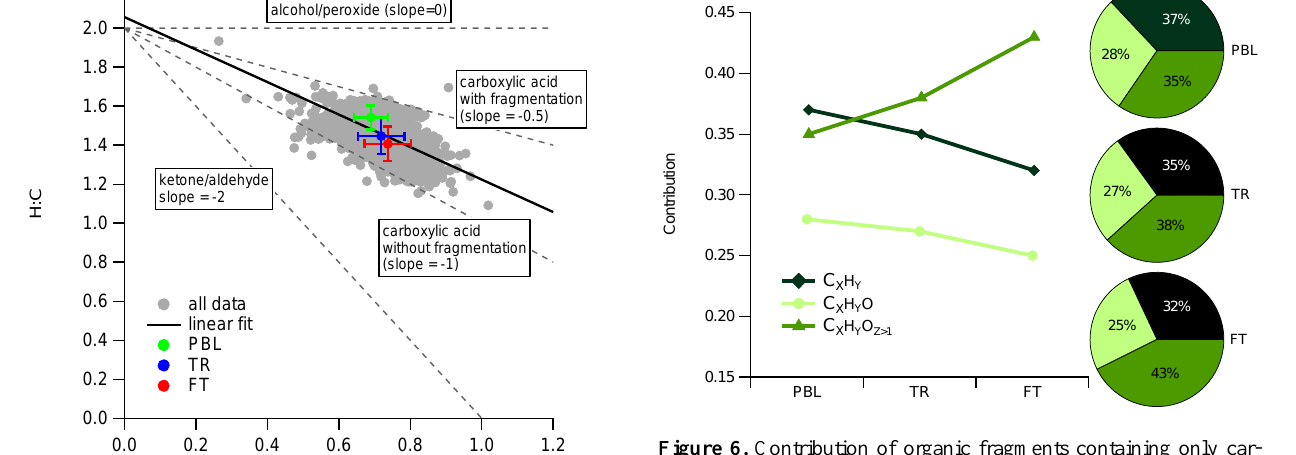
Figure 6. Contribution of organic fragments containing only car- bon and hydrogen (C x H y ), organic fragments containing carbon, hydrogen and one oxygen atom (C x H y O 1 ) and organic fragments containing carbon, hydrogen and more than one oxygen atom (C x H y O z> 1 ) in PBL, TR and FT